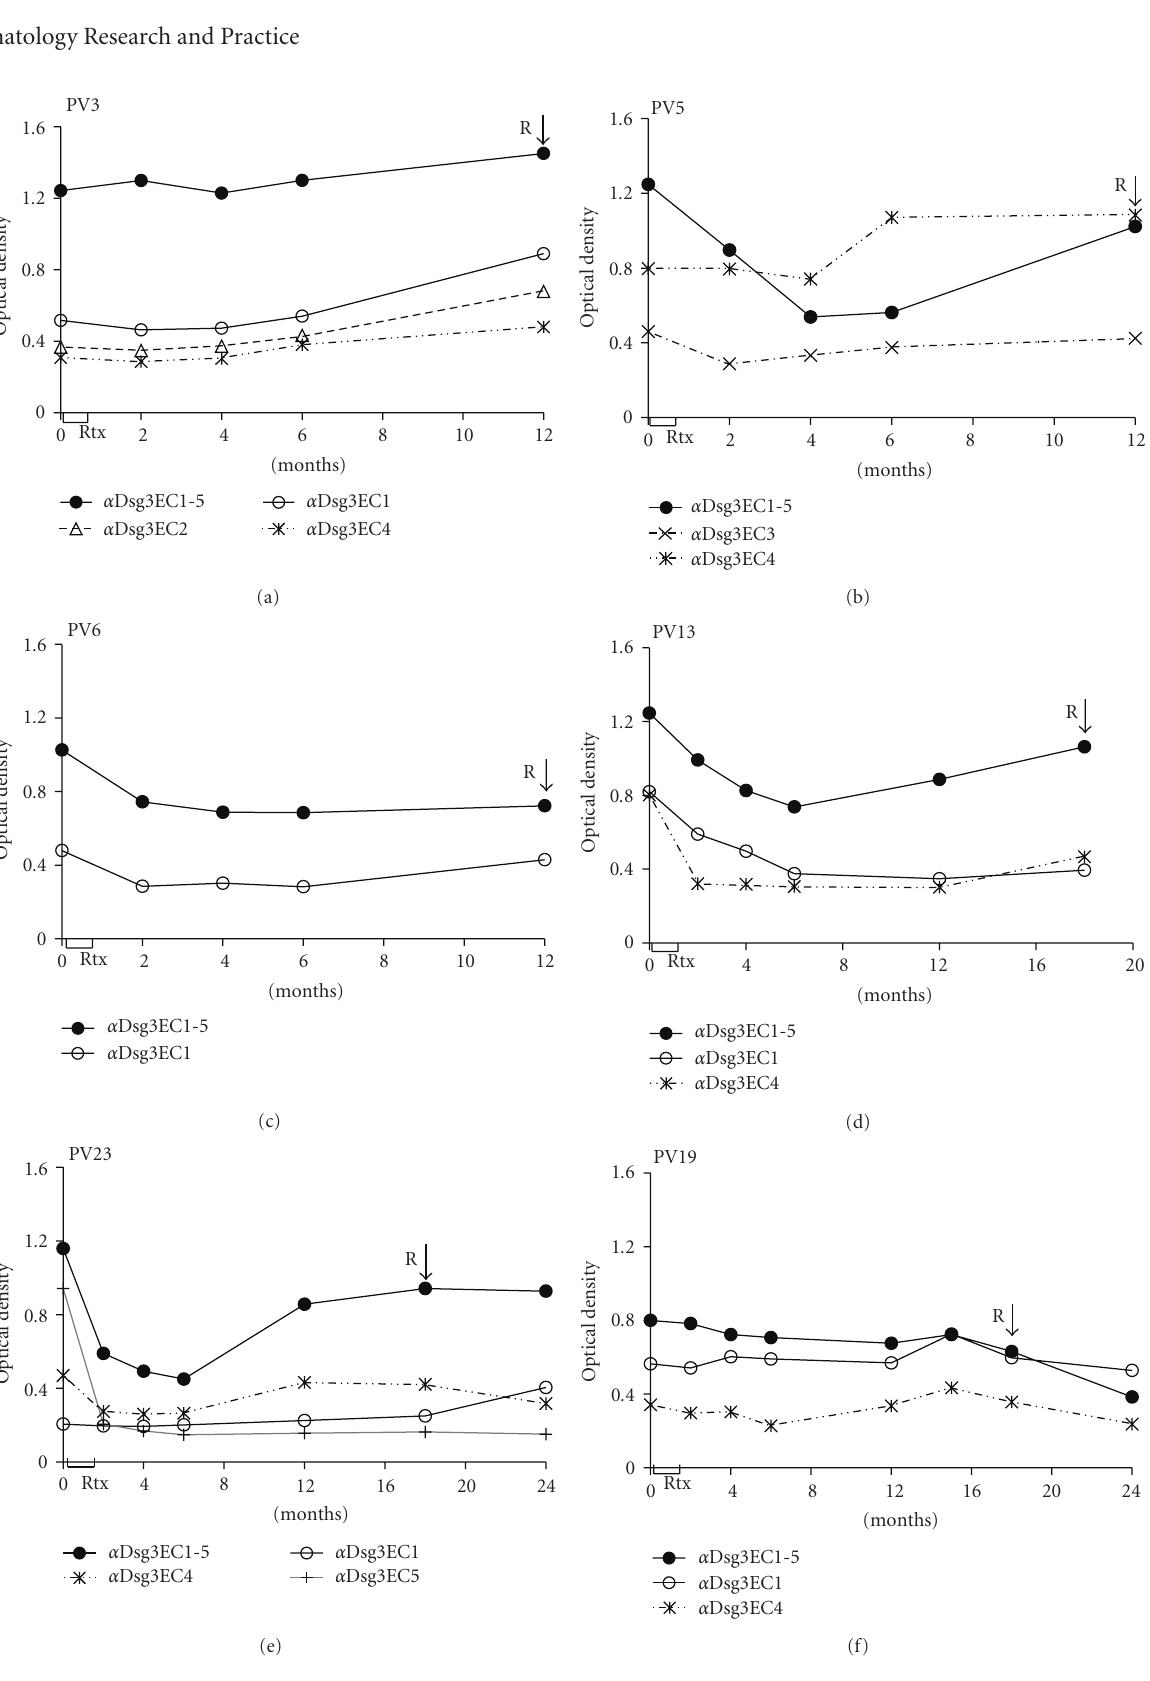
Figure 3: Association of clinical relapses of rituximab (Rtx)-treated pemphigus vulgaris (PV) patients and the reappearance of IgG against distinct regions of the Dsg3 ectodomain. Three of the 6 PV patients (PV3, PV6, PV23) showed an increase of IgG reactive with the Dsg3EC1 subdomain upon clinical relapse after Rtx therapy. Patient PV13 showed increased serum levels of IgG against the Dsg3EC4 subdomain while patients PV5 and PV19 did not show altered IgG levels against any of the studied Dsg3 subdomains upon clinical